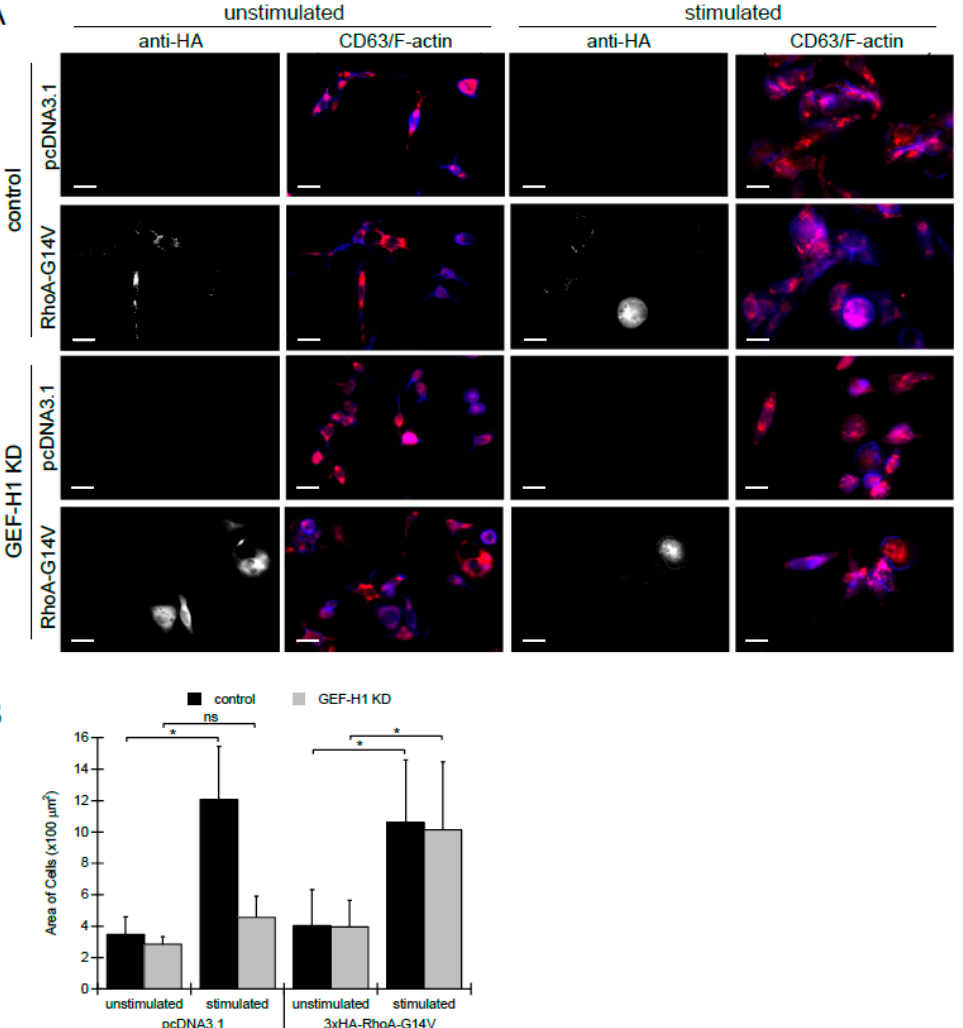
Figure 6. Expression of constitutively active RhoA-G14V in GEF-H1-depleted cells rescues defects in granule trafficking and cell spreading. 3xHA-tagged RhoA-G14V, a constitutively active mutant of RhoA, was transfected into control and GEF-H1-depleted (GEF-H1 KD) RBL-2H3 cells. pcDNA 3.1 was used as an empty vector control. Granules were labeled with anti-CD63 antibody ( red ) and F-actin was labeled with Alexa Fluor 405-phalloidin ( blue ). Anti-HA labeling ( grayscale ) indicated transfected cells. ( A ) Images show that the expression of 3xHA-RhoA-G14V rescues defects of both granule distribution and cell spreading after antigen stimulation ( 30 min ) of GEF-H1-depleted cells. Scale bar = 20 µ m. ( B ) Quantification of cell size by ImageJ analysis. When stimulated, the knockdown of GEF-H1 prevented cell spreading, while the expression of RhoA-G14V in GEF-H1- depleted cells restored cell spreading. For statistical analysis, the size of 4 to 6 cells per condition (replicate measurements) was averaged from three independent experiments. Differences in cell size between samples were analyzed by Kruskal–Wallis tests ( p = 0.00794). Dunn’s post hoc tests were used to identify significant differences between the size of unstimulated and stimulated cells (* p = 0.0243 for control and not significant (ns) for GEF-H1 KD cells transfected pcDNA3.1; * p = 0.0327 for control and * p = 0.0433 for GEF-H1 KD cells transfected with